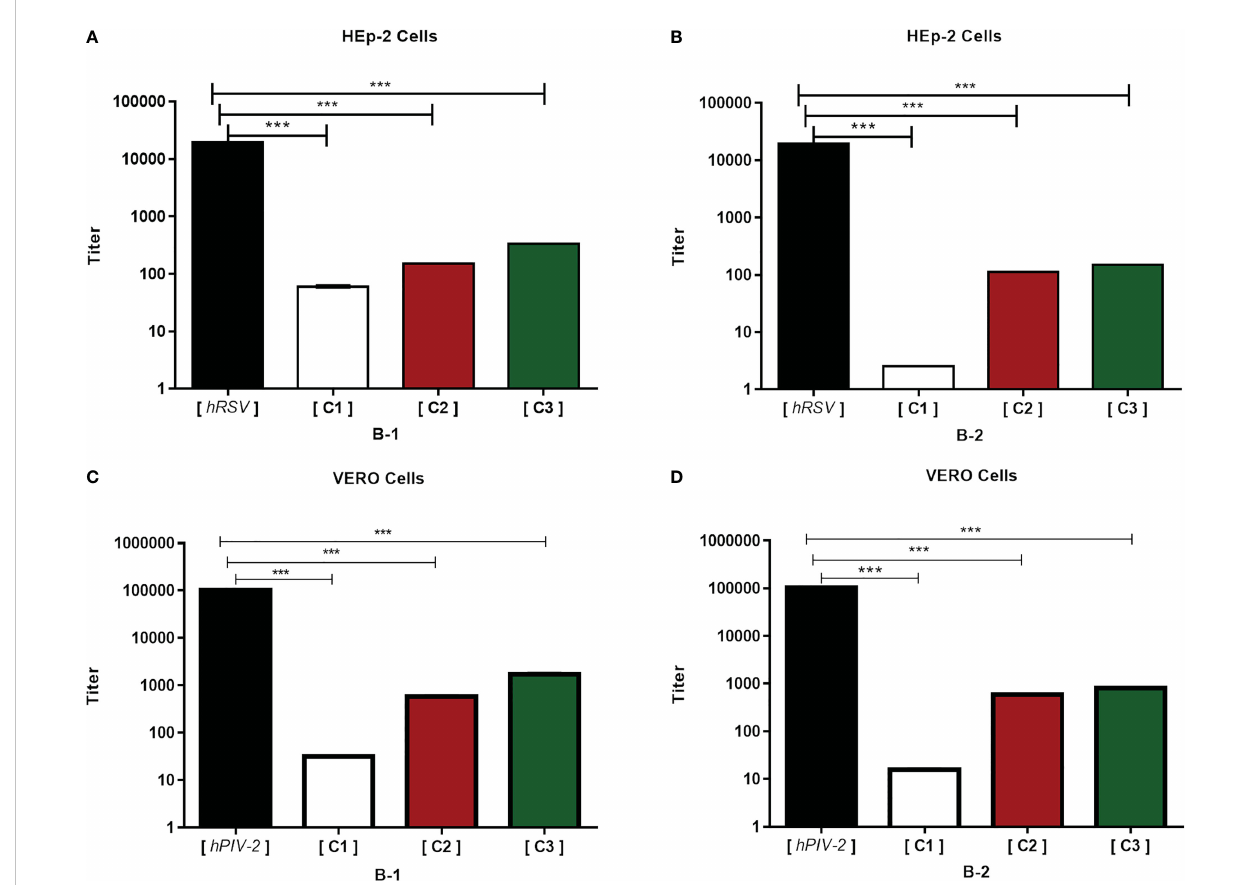
FIGURE 2 HRA2pl reduces the viral titer. For the assay, a con fl uent monolayer of HEp-2 (A, B) and Vero (C, D) cells (95% – 100%) was treated with HRA2pl puri fi ed in DMEM at three different concentrations (C1: 3.2 µg/mL; C2: 2.1 µg/mL; C3: 1.8 µg/mL). The monolayers were treated with a mixture of C1, C2, or C3 and hRSV (1.9 × 10 4 TCID 50 /ml) and hPIV-2 (1 × 10 5 TCID 50 /ml). The reduction in the viral titer was established by TCID 50 / ml .***p<